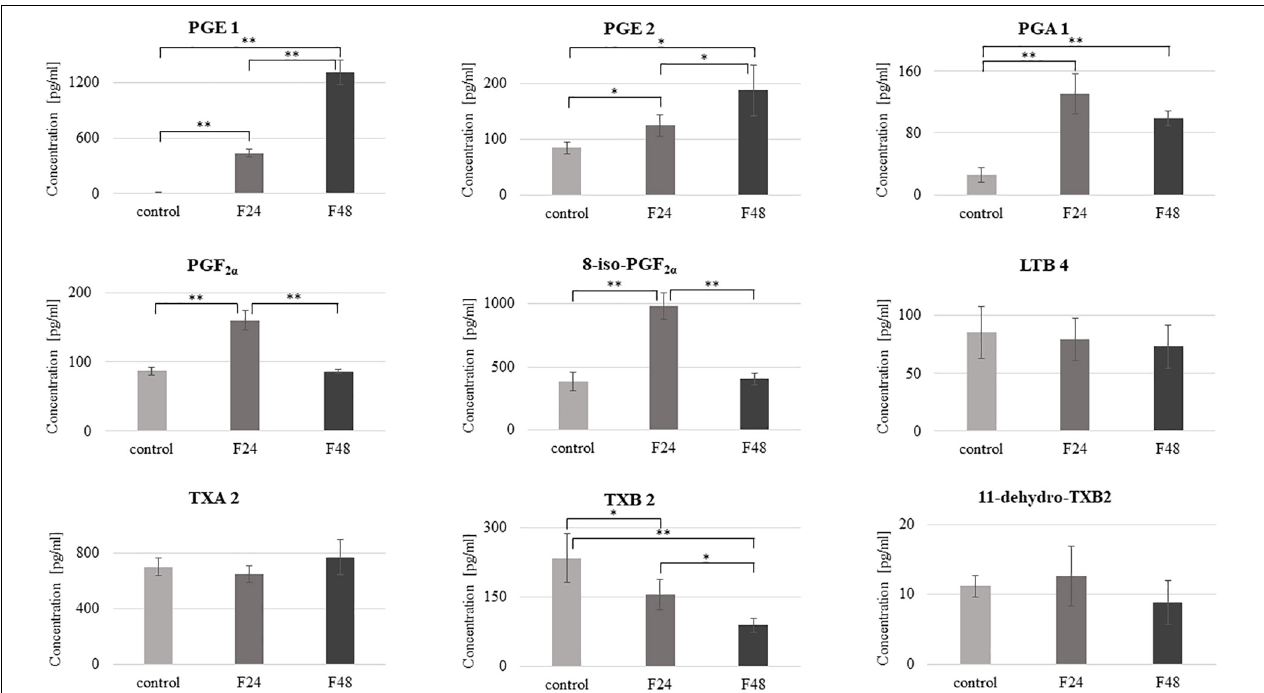
FIGURE 5 | Concentration of selected eicosanoids in the hemolymph of G. mellonella larvae after infection with C. coronatus. The measurements were performed using ELISA tests. Data are presented as means and standard deviations. ∗ p ≤ 0.05, ∗∗ p < 0.001 (Student’s t -test, p ≤ 0.05). Control, non-infected, healthy larvae; F24, larvae sampled immediately after 24-h exposure to C. coronatus sporulating colonies; F48, larvae sampled 24 h after 24-h exposure.